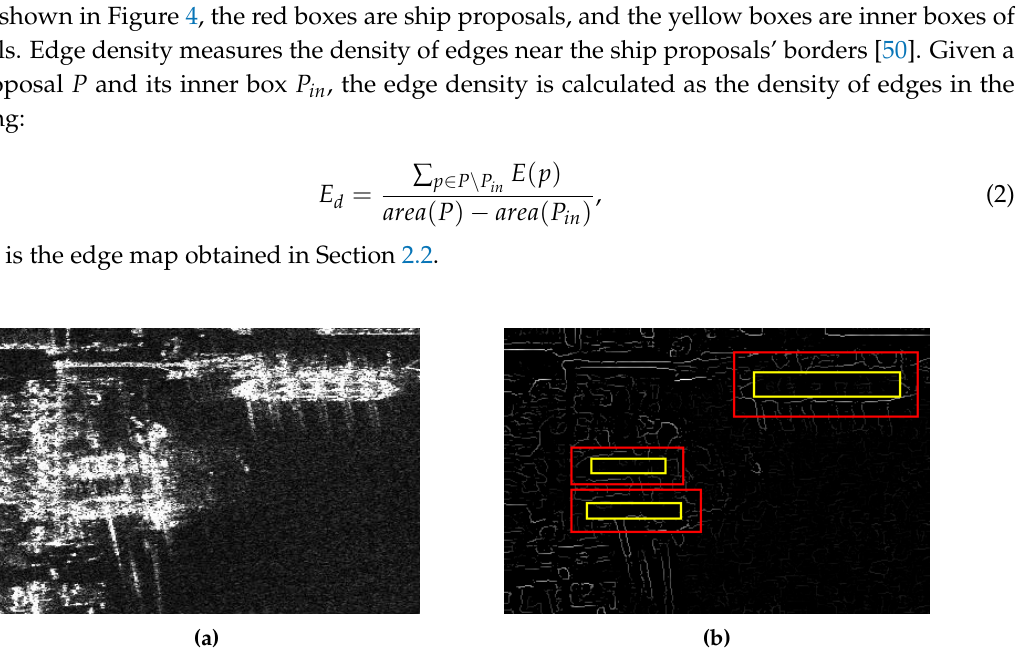
Figure 4. Edge scoring of ships. ( a ) original synthetic aperture radar (SAR) images; ( b ) edge map with ship proposals. The red boxes are ship proposals ( P ), and the yellow boxes are inner boxes of the proposals ( P in